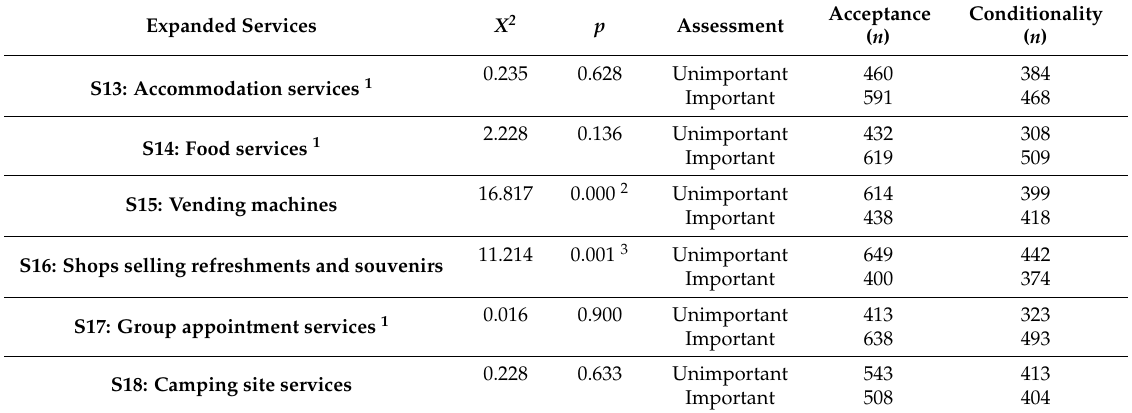
Table 5. Perceptions of the importance of expanded services by segment.